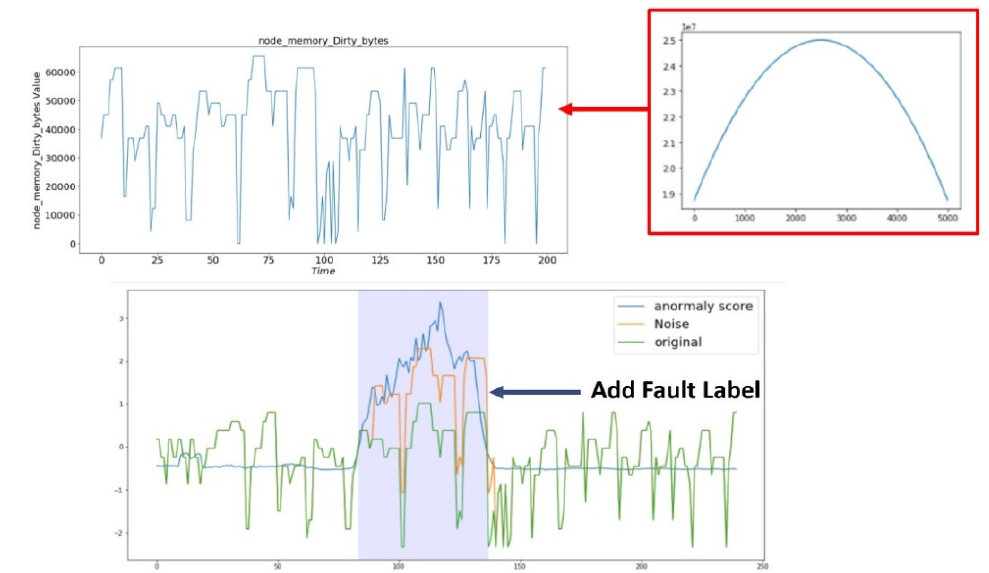
Figure 14. Feature Importance Test.